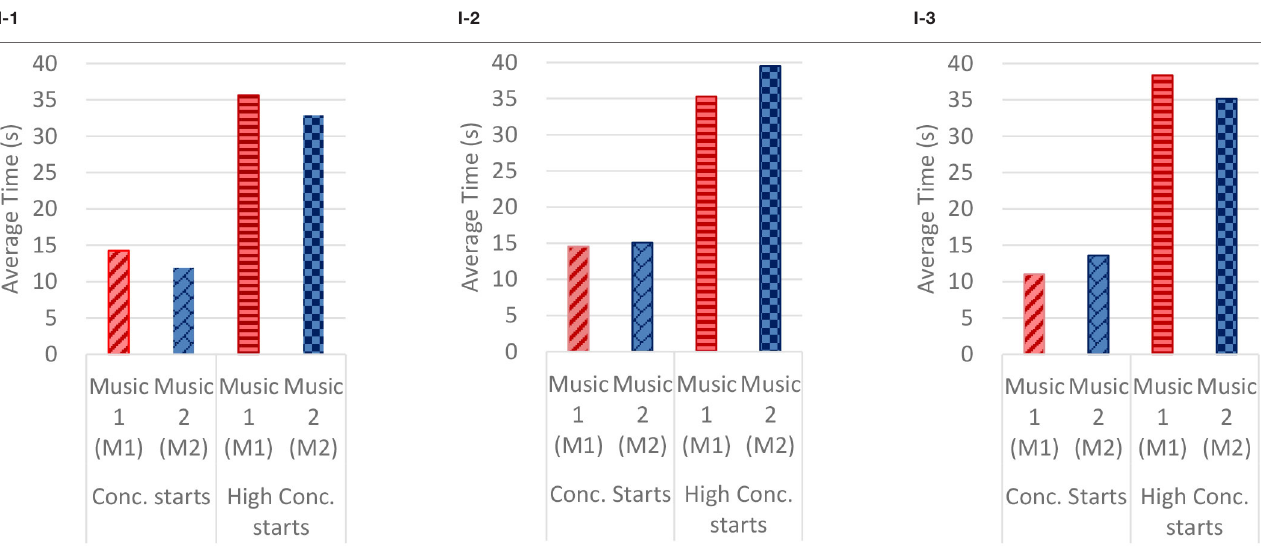
TABLE 4 | Average time to concentration and high